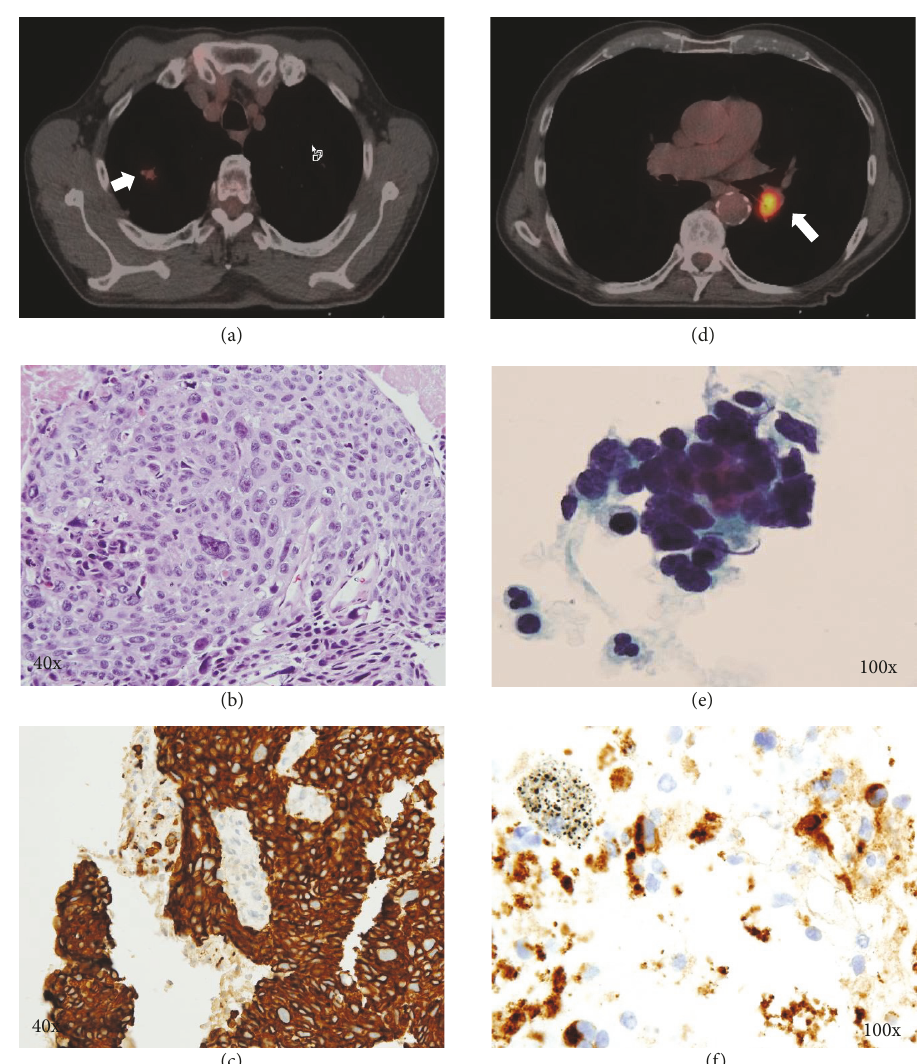
Figure 1: Positron emission tomogram showing mild [ 11 F]-2-fluoro-2-deoxy-D-glucose (FDG) uptake in the right upper lobe lesion (a) (short white arrow), diagnosed as squamous cell carcinoma on biopsy ((b) hematoxylin and eosin, 40x; (c) CK5 immunostain, 40x). (d) A highly FDG-avid left infrahilar mass (long white arrow) that was diagnosed as small cell carcinoma after biopsy analysis ((e) hematoxylin and eosin, 100x; (f) synaptophysin,